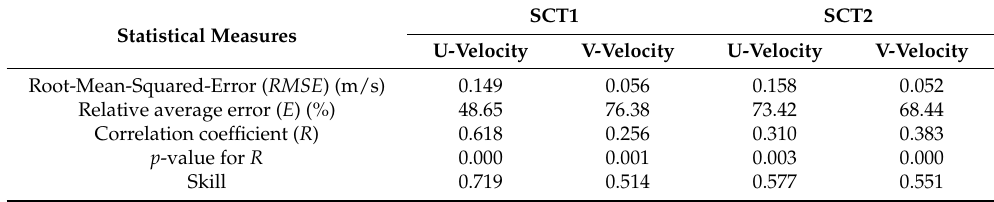
Table 2. Results of statistical analysis between model simulations and